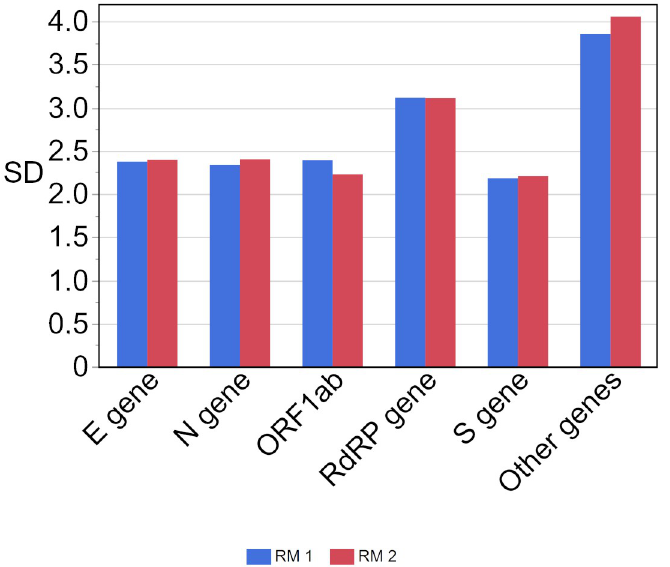
Fig 5. Standard deviation (SD) for the respective Ct value results per gene region. The concentration of RM 1 (blue) is estimated at roughly 10 7 copies/mL and the concentration of RM 2 (red) is estimated at roughly 10 6 copies/